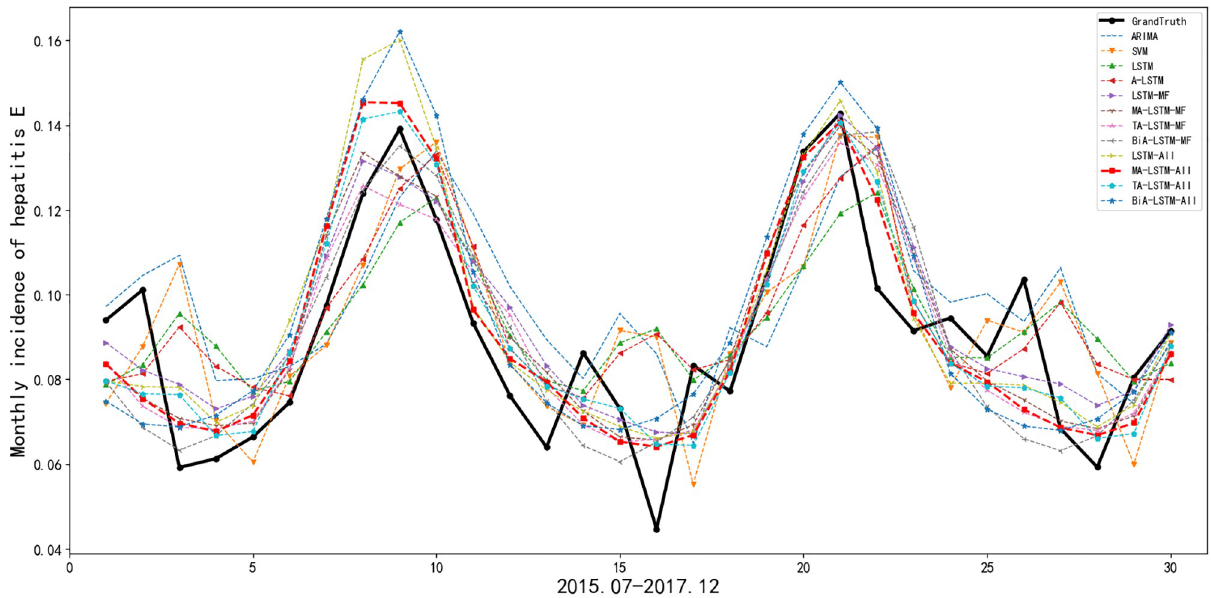
Fig 5. Prediction values of monthly incidence of hepatitis